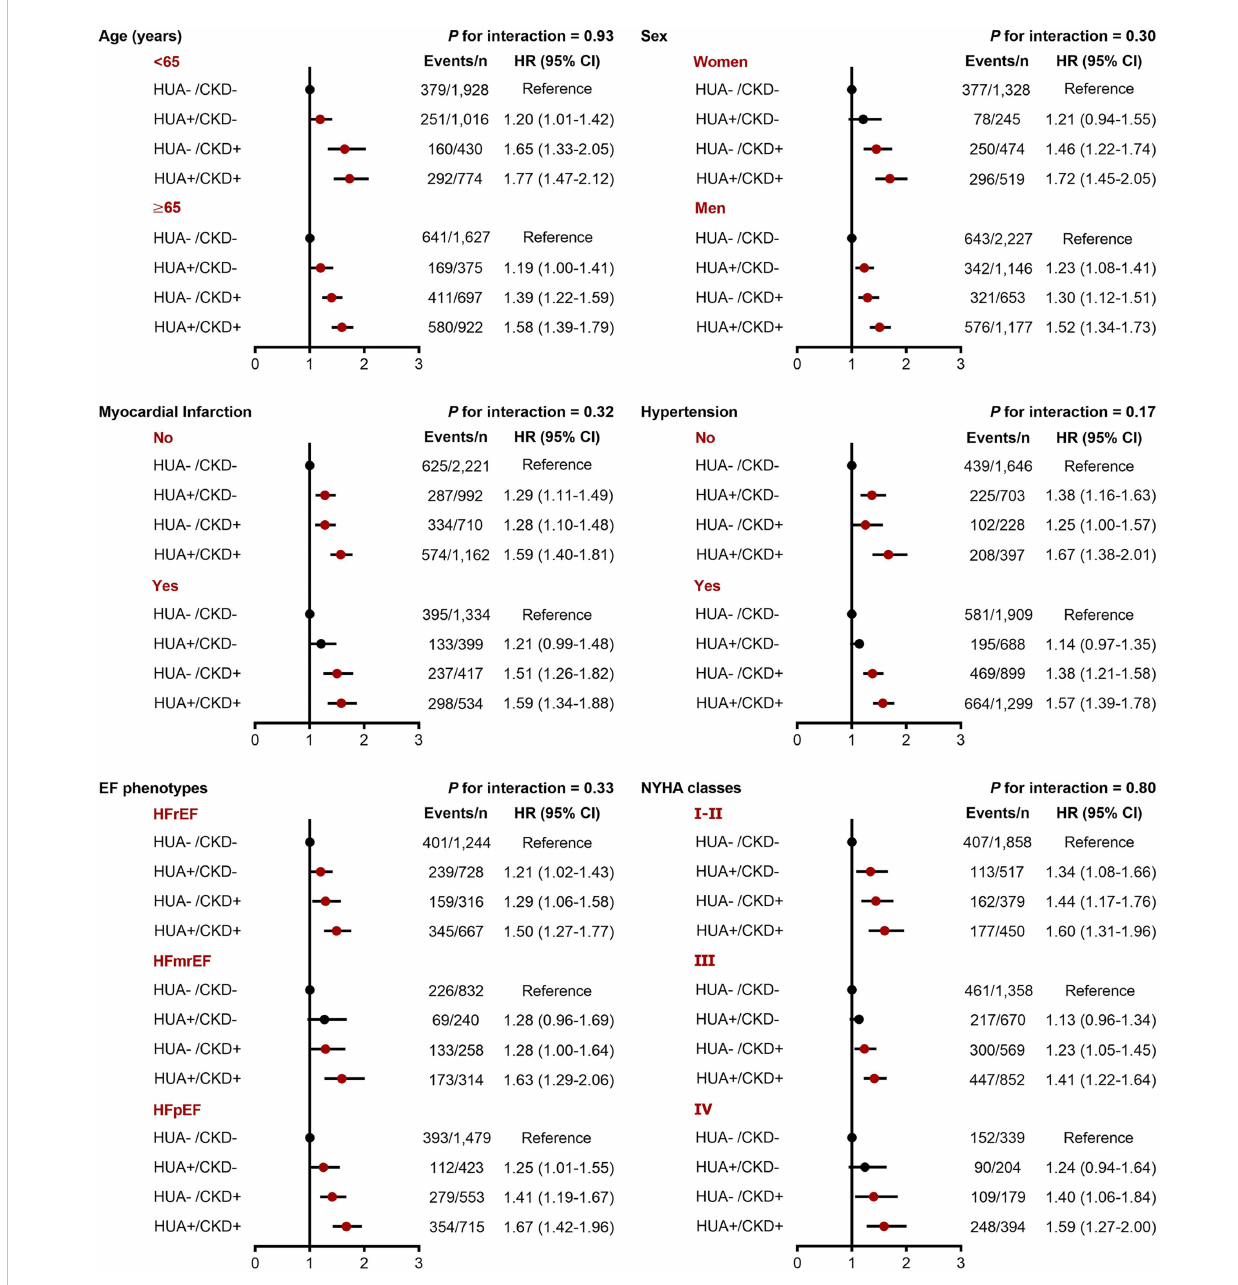
FIGURE 3 Subgroup analyses for the adjusted HR (95% CI) of hyperuricemia/CKD groups for long-term mortality by age, sex, myocardial infarction, hypertension, EF phenotype, and NYHA classi fi cation. CI, con fi dence interval; CKD, chronic kidney disease; EF, ejection fraction; HFmrEF, heart failure with mildly reduced ejection fraction; HFpEF, heart failure with preserved ejection fraction; HFrEF, heart failure with reduced ejection fraction; HR, hazard ratio; HUA, hyperuricemia; NYHA, New York Heart